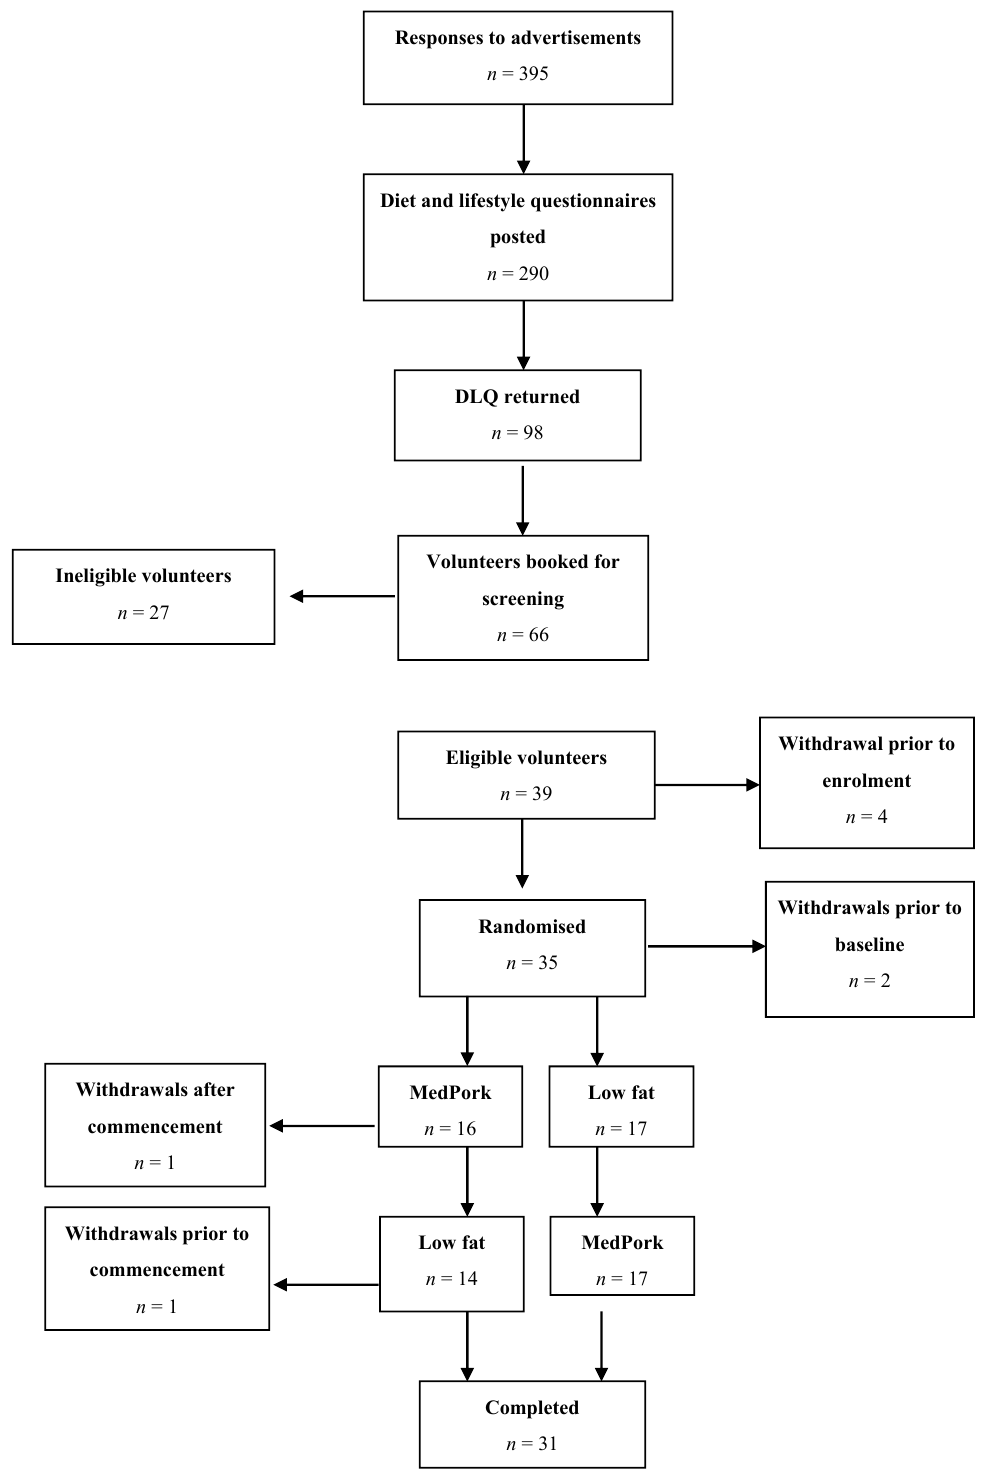
Figure 1. Consort diagram illustrating the flow of the participants from recruitment through to study completion. The intention-to-treat analysis is based on all the participants with baseline data ( n =